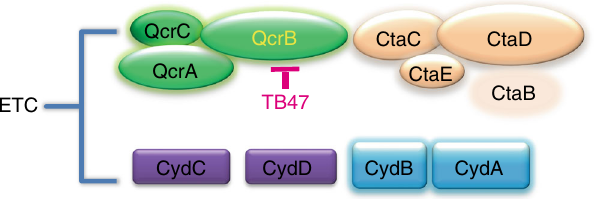
Fig. 4 Two terminal oxidases in the electron transport chain of mycobacteria. Mutations in QcrB in the cytochrome bc1:aa3 confer resistance to TB47